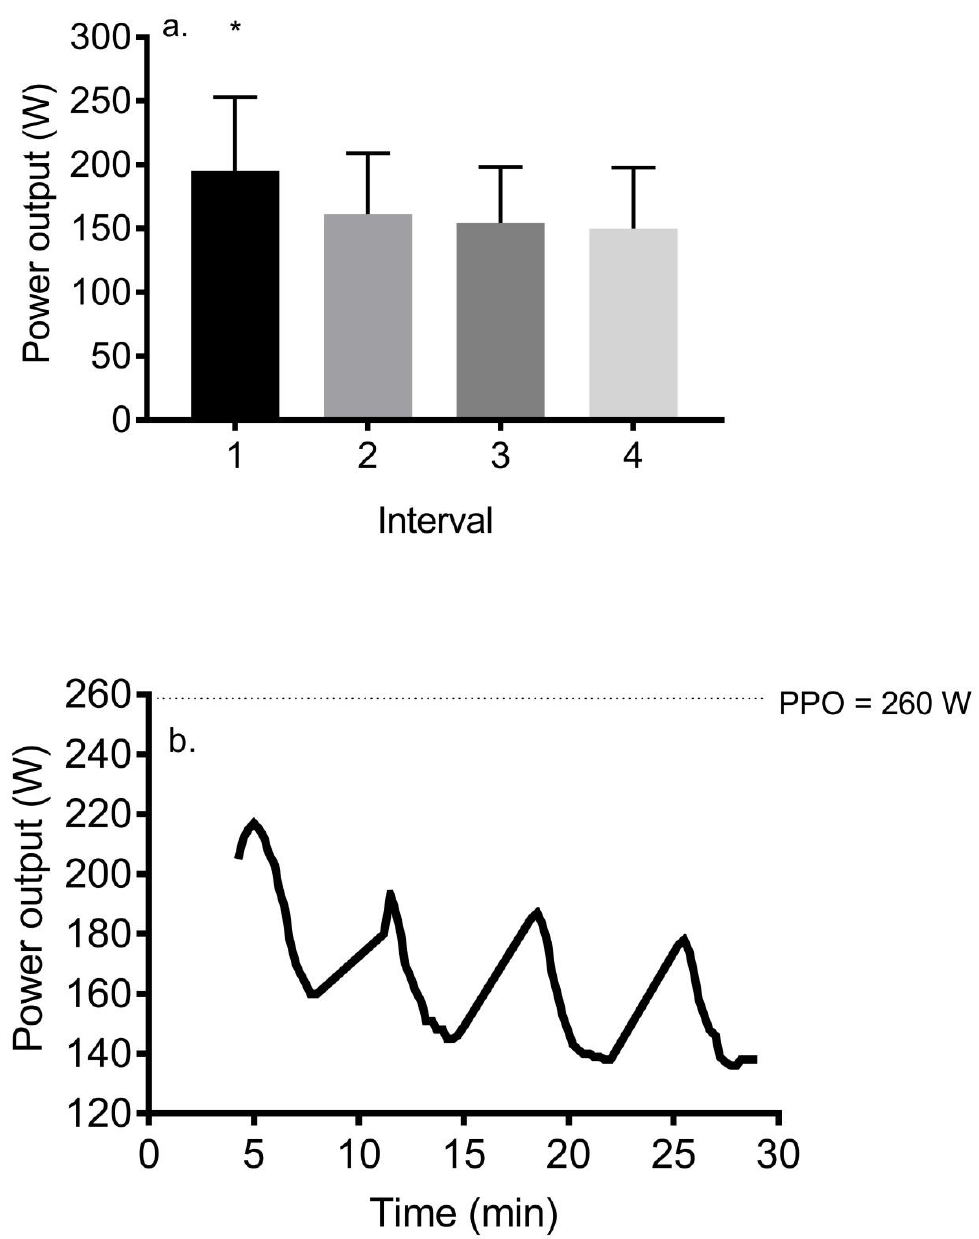
Figure 2. ( a ) Mean power output response to each of the four intervals during the 4 × 4 protocol (mean ± SD). * = p < 0.05 versus intervals 2–4; ( b ) overall power output response during the 4 × 4 protocol for all 39 participants. Note that minutes 4–8, 11–15, 18–22, and 25–29 represent the four intervals of the